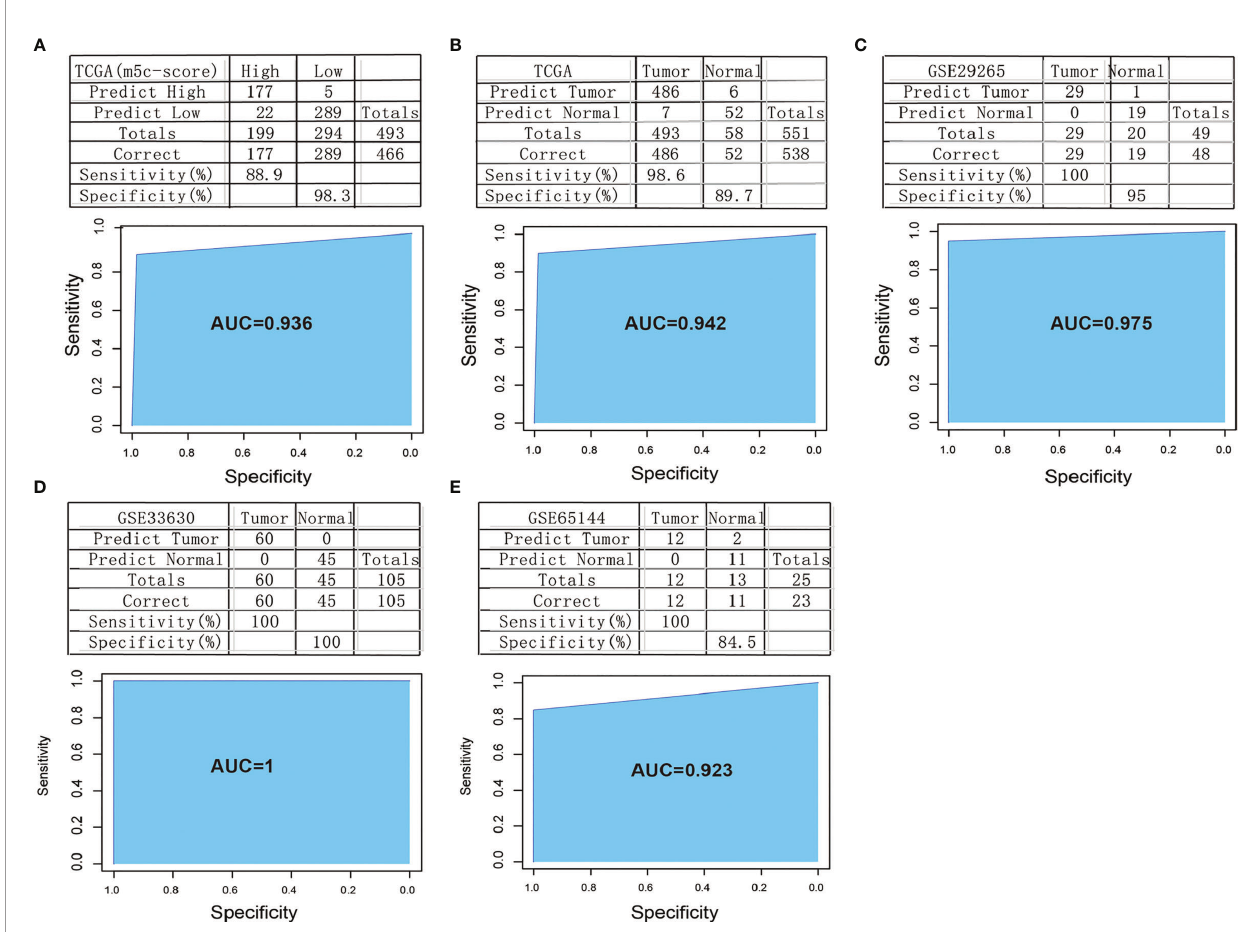
FIGURE 7 | Construction and veri fi cation of the m 5 C-score-based PTC diagnostic model. (A) Comparison of classi fi cation results of TCGA-PTC samples by diagnostic model constructed based on 10 signature genes and the m 5 C-score. (B) Accuracy of classi fi cation of TCGA samples by a diagnostic model constructed based on 10 signature genes. (C – E) Accuracy of classi fi cation of samples in GSE29265 (C) , GSE33630 (D) , and GSE65144 (E) by a diagnostic model constructed based on 10 signature